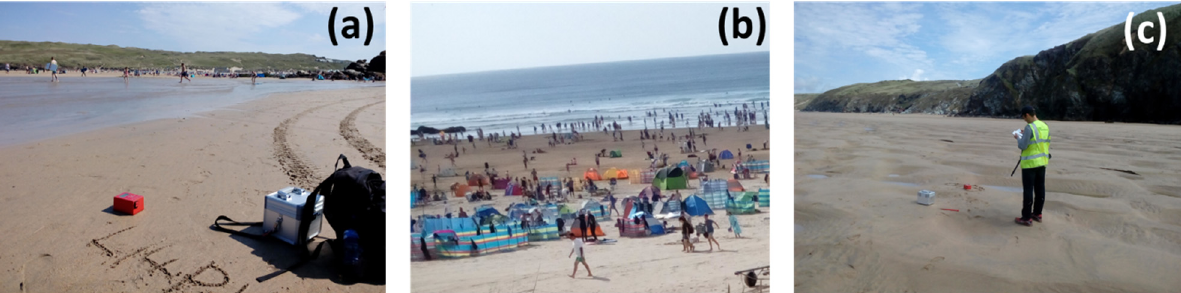
Figure 6. Field survey was conducted in the summer season: ( a ) shows typical distance between beach users and Tromino unit, ( b ) portable wind breakers deployed by beach users during the survey, and ( c ) member of staff using a high visibility jacket to indicate location and indicate beach users not to get too close to the unit while sampling (Source BGS).